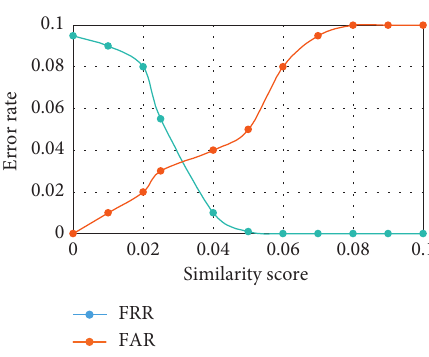
Figure 7: Equal error rate for the DRIVE database.